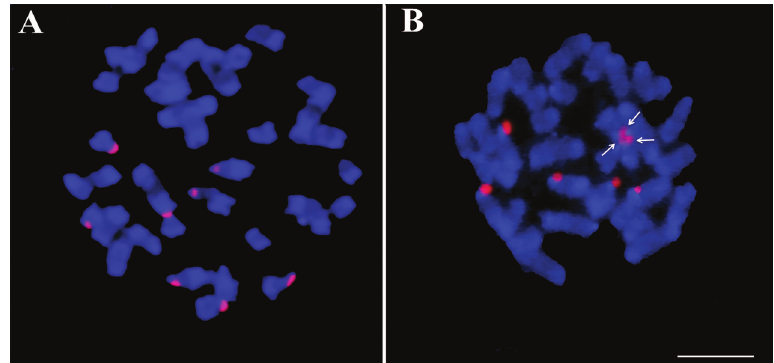
Figure 4. FISH molecular cytogenetic analysis with rDNA. FISH on metaphase spreads of cultivated cardoon ( A ) and globe artichoke ( B ) using the rDNA probe pTa71-Cy3 (red fluorescence). In Fig. 3B, arrows point to the hybridization spots localized on the three small acrocentric chromosomes, placed head to head. Scale bar: 5 µm.